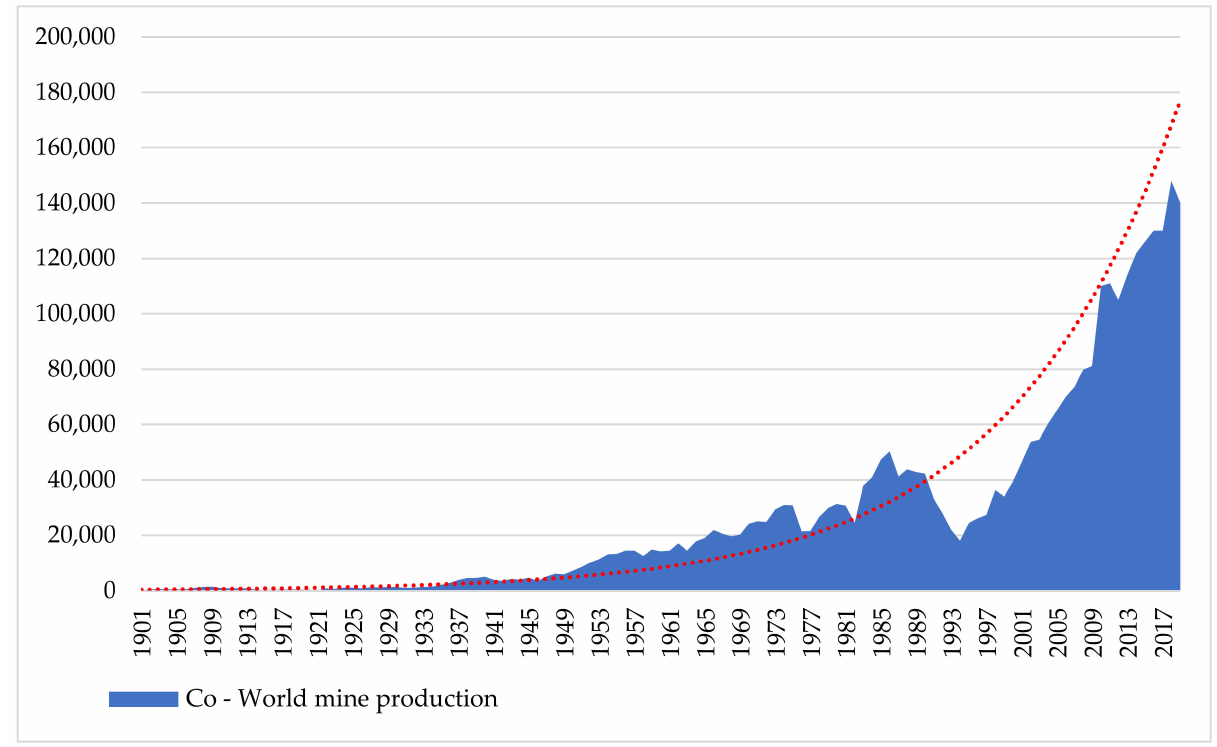
Figure A1. Global mine production of Co per thousand tons (build on the data from [25]), the red line is a trend.